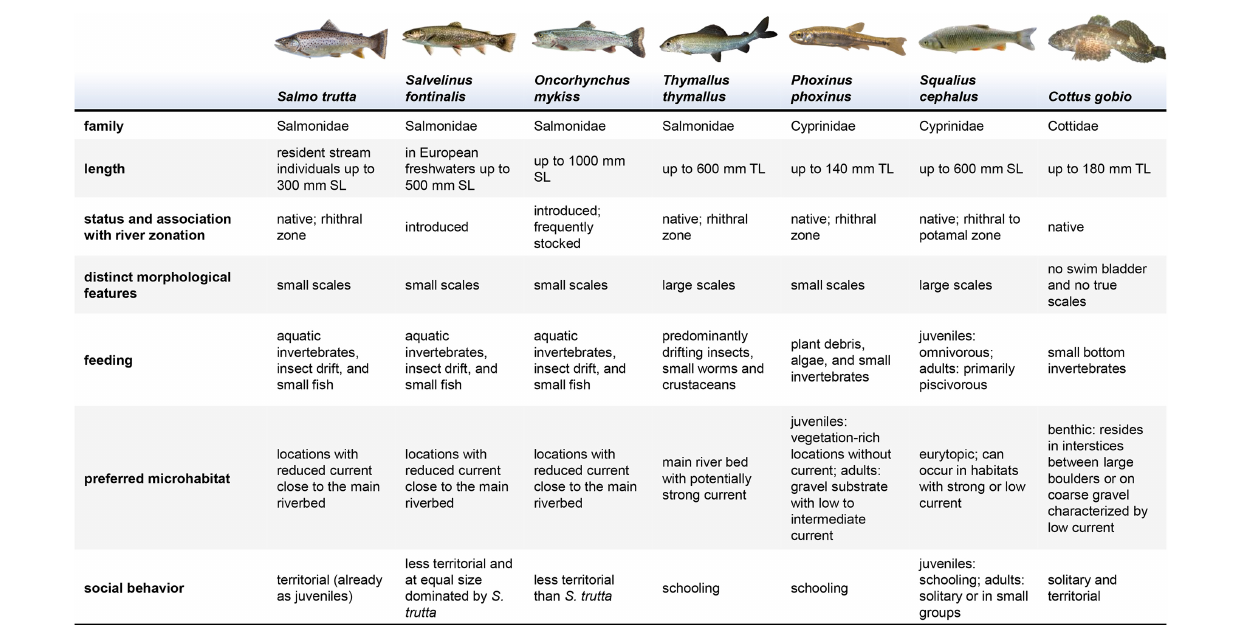
FIGURE 1 | A summary of the morphological and ecological traits of the fish species used in the aquarium experiment. The provided information describes the situation in Central European freshwaters and is not necessarily transferable to other geographic regions. Depending on the source, different maximum fish length measurements were available with “total length (TL)” measured from the tip of the snout to the longest tip of the caudal fin and “standard length (SL)” measured from the tip of the snout to the base of the caudal fin (Muus and Dahlström, 1968; Spindler, 1997; Freyhof and Kottelat, 2007) (https://upload.wikimedia.org/wikipedia/ commons/b/bb/CottusGobioSpreadingFins.JPG separated from background; Piet Spaans, CC BY-SA 2.5; https://creativecommons.org/licenses/by-sa/2.5, via Wikimedia Commons; https://upload.wikimedia.org/wikipedia/commons/9/99/Thymallus_thymallus2.jpg separated from background; Gilles San Martin, CC BY-SA 2.0 https://creativecommons.org/licenses/by-sa/2.0, via Wikimedia